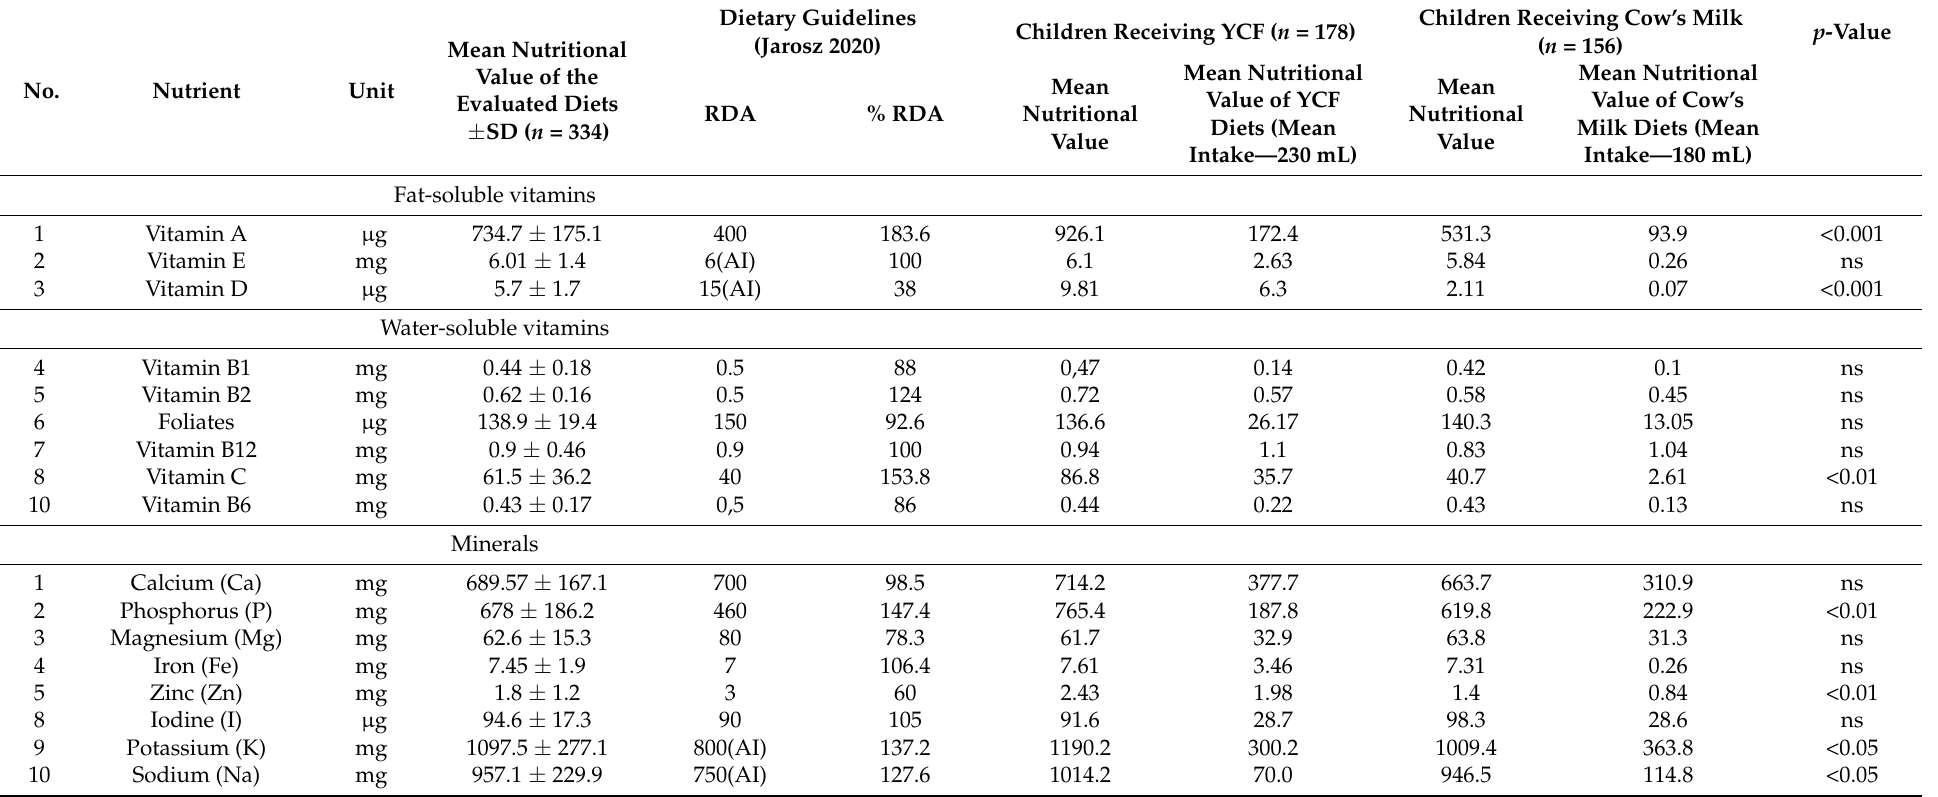
Table 5. Energy and nutritional value of the evaluated diets of children aged 13–24 months vs. dietary guidelines and expert